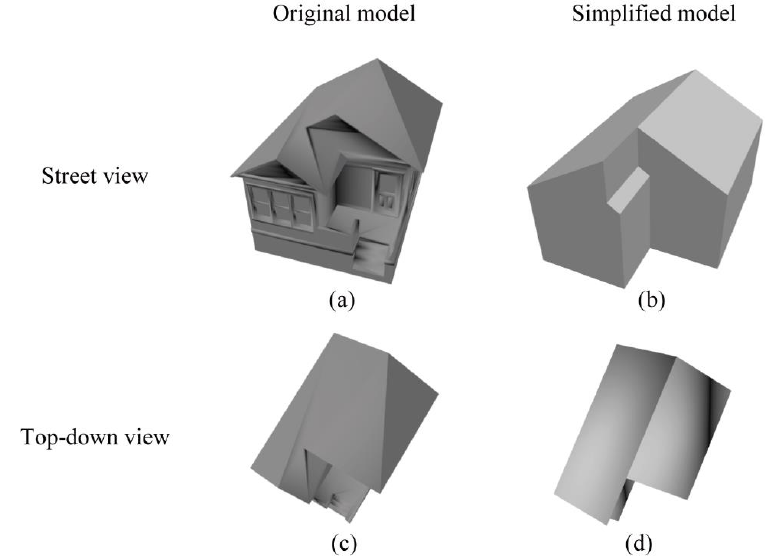
Figure 8. Simplification of a 3D building with sloped roofs: ( a ) original model in street view; ( b ) simplified model in street view; ( c ) original model in top-down view; and ( d ) simplified model in top-down view.